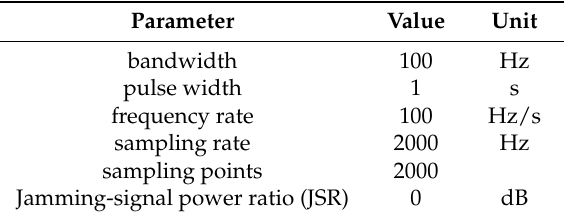
Table 1. Parameter settings.